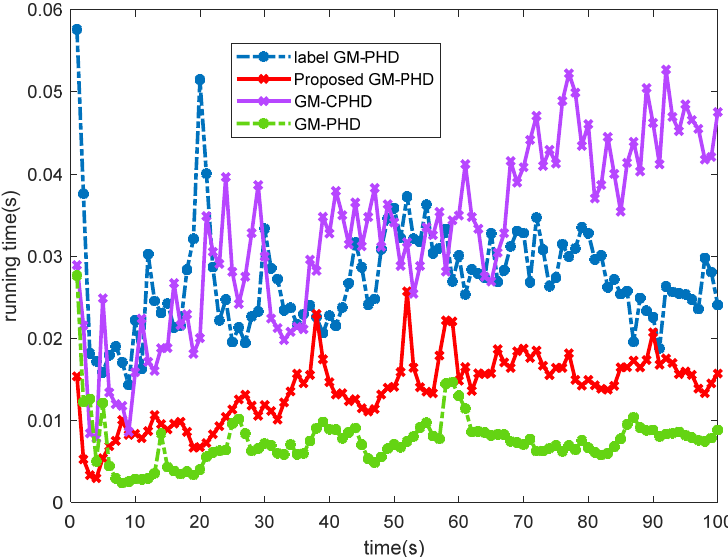
Figure 3. Different algorithm running time.